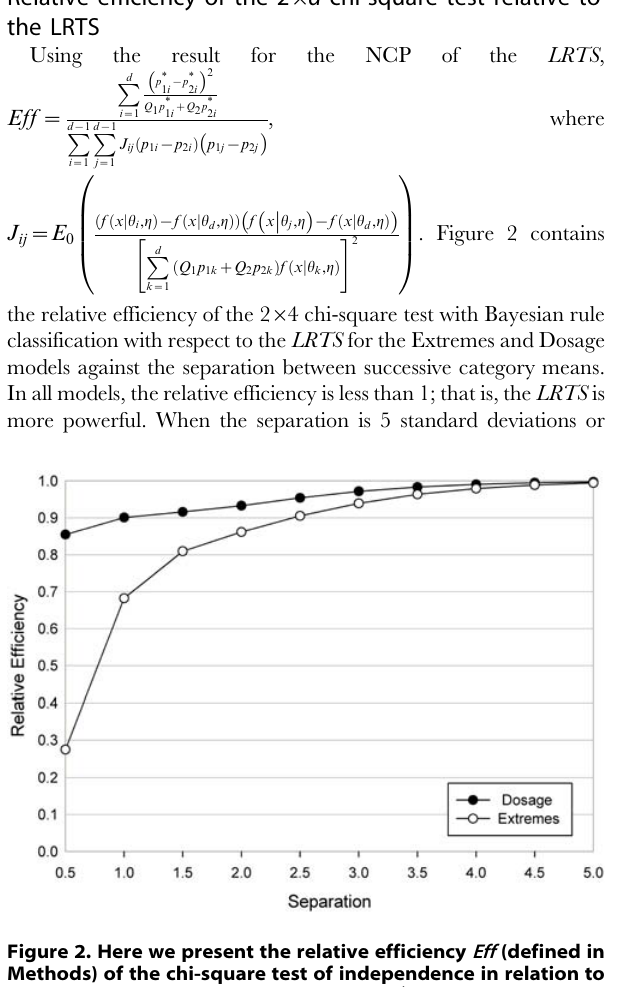
Legend for Table 2. Based on 1000 replications and 200 sample size per case/control group. * 95% approximate confidence intervals for simulated power are given in parentheses. Here, we present simulated and asymptotic power for the LRTS when the alternative hypothesis that mixing proportions are different in each of two groups is true. The mixing proportions are computed using equations (4) for the Dosage and Extremes models, where CNP population frequencies are as specified above (Methods - Genetic model parameters for efficiency analysis). For the Dosage model, the relative risks are: R 2 =1.8, R 3 =1.8 2 =3.64, R 4 =1.8 3 =5.83. For the Extremes model, the relative risks are: R 1 =1, R 2 =0.3, R 3 =0.3, R 4 =1. Asymptotic power is computed using the non-centrality parameter documented in equation (A1). The column ‘‘KS-Test P-value’’ refers to the p-value computed using the Kolmogoroff-Smirnoff goodness of fit test, as implemented in R programming environment.